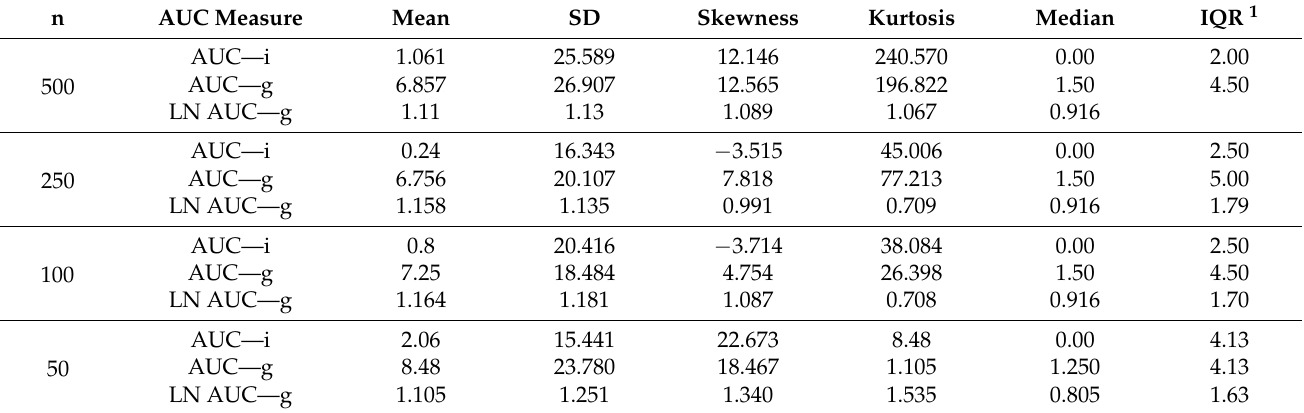
Table 3. Descriptive statistics for the AUC